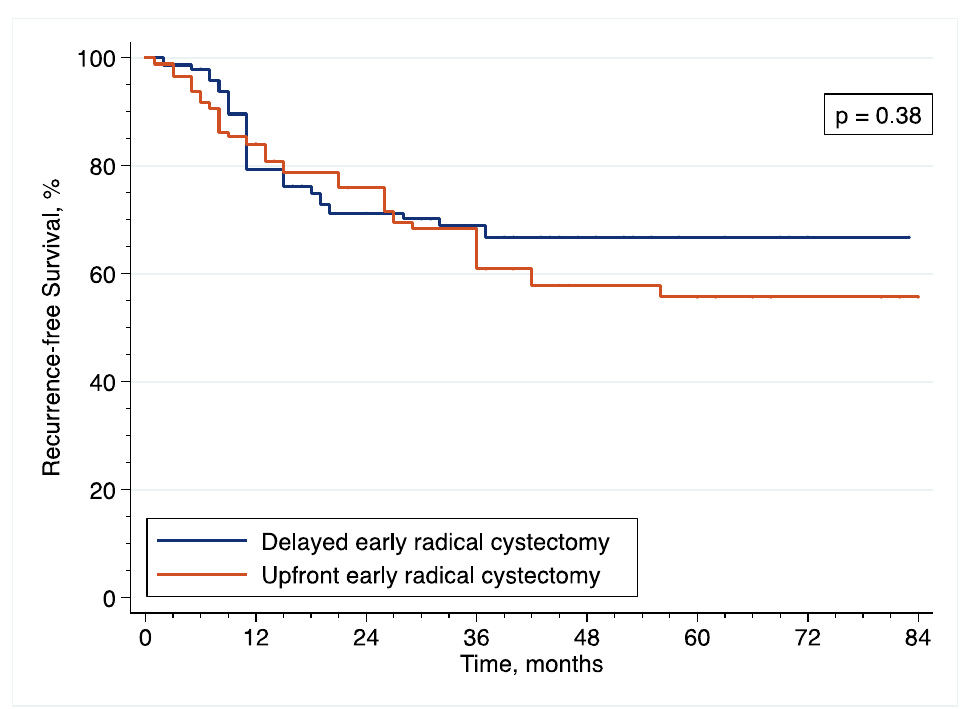
Figure 6. Inverse probability of treatment weighting (IPTW)-adjusted Kaplan–Meier curves that compare the RFS of included patients treated with upfront or delayed eRC for HR-NMIBC.